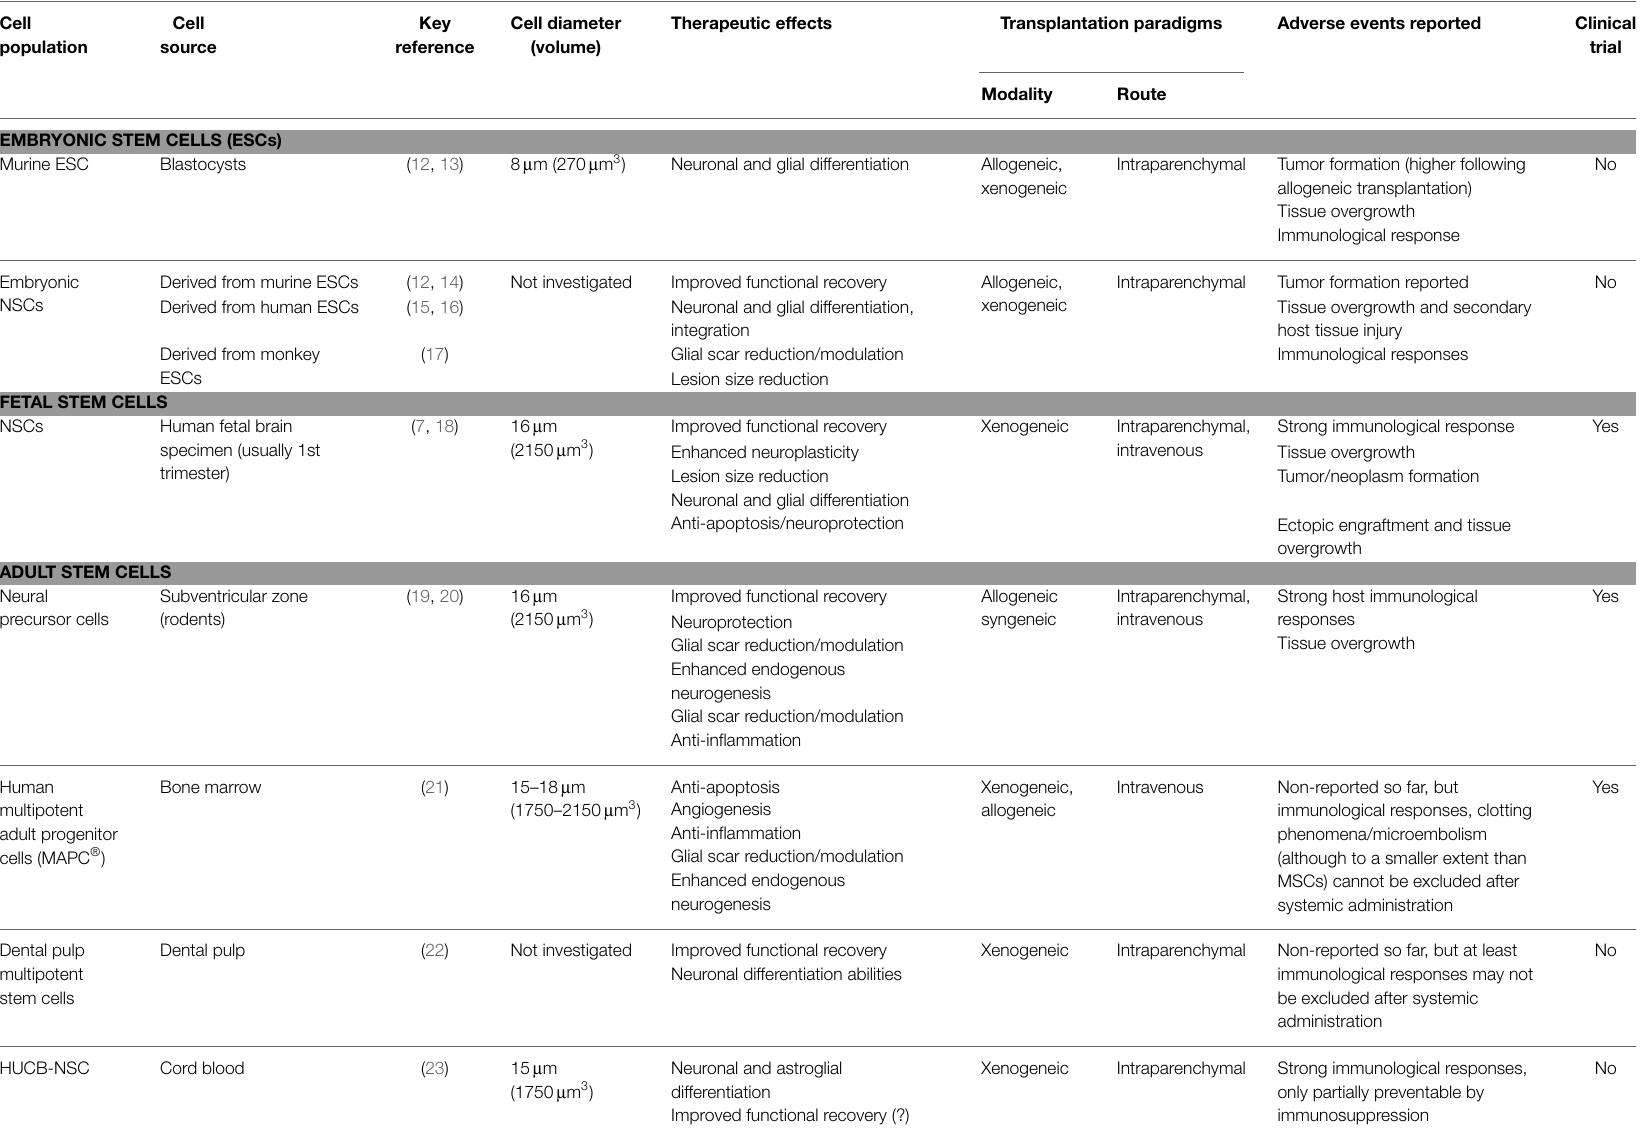
TABLE 1 | Overview on cell populations being investigated for stroke therapy